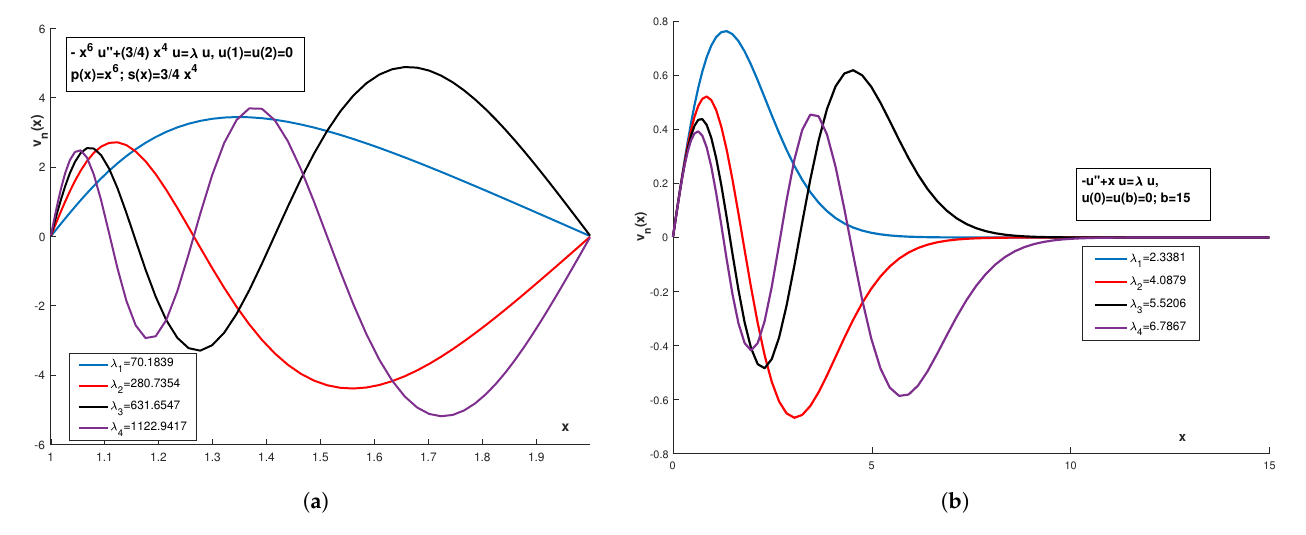
Figure 2. ( a ) Collatz problem; ( b ) Airy problem.